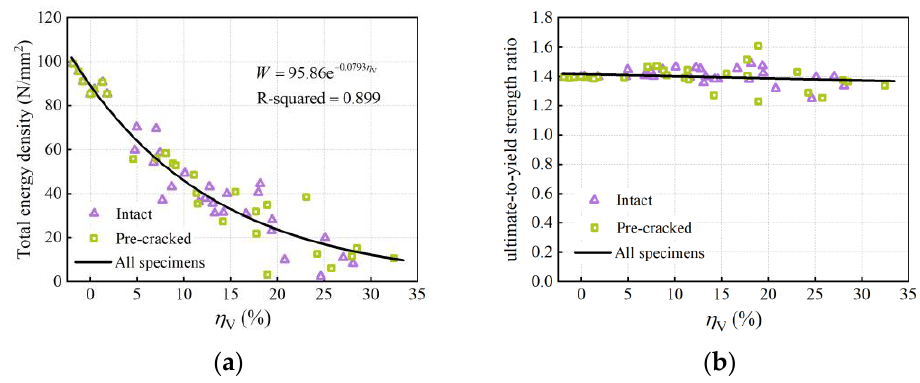
Figure 17. Effect of corrosion on: ( a ) energy density; ( b ) ultimate-to-yield-strength ratio.